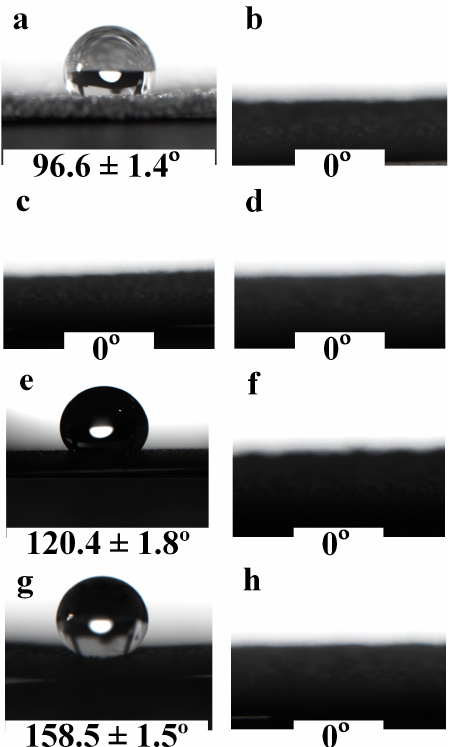
Figure 6. WCA and OCA shadowgraphs for ( a , b ) untreated Cu foam; ( c , d ) laser-textured Cu foam; ( e , f ) heat treated Cu foam and ( g , h ) laser-heat treated Cu foam.